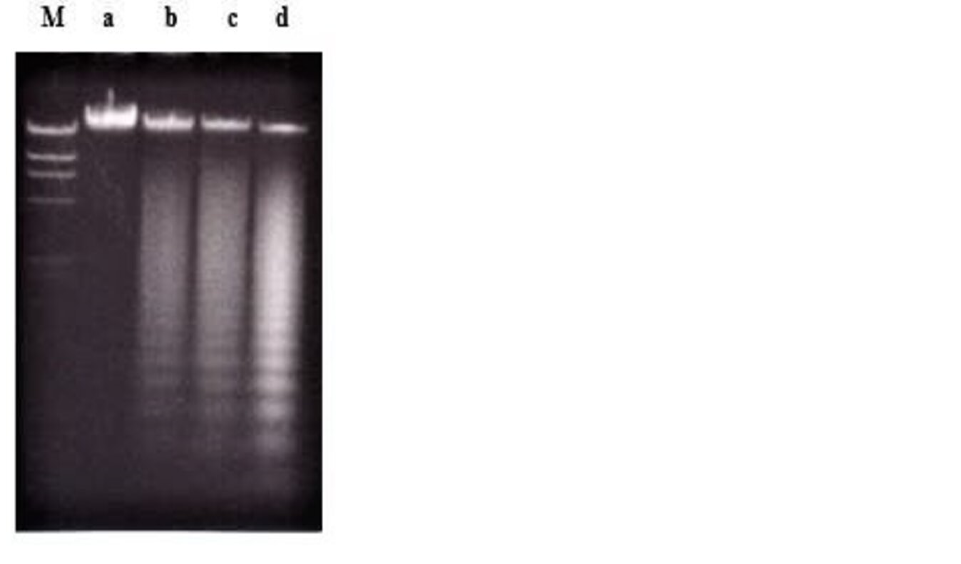
Figure 10. The involvement of RNA synthesis in damnacanthal-induced apoptosis in CEM-SS cells at 24 h. Actinomycin D failed to prevent apoptosis induced by 30 μg/mL of damnacanthal at 24 h. Lane a: control. Lane b: damnacanthal (30 μg/mL). Lane c: actinomycin D (1 μg/mL). Lane d: damnacanthal (30 μg/mL) + actinomycin D (1 μg/mL). Lane M: Marker (HindIII digest of lambda DNA).